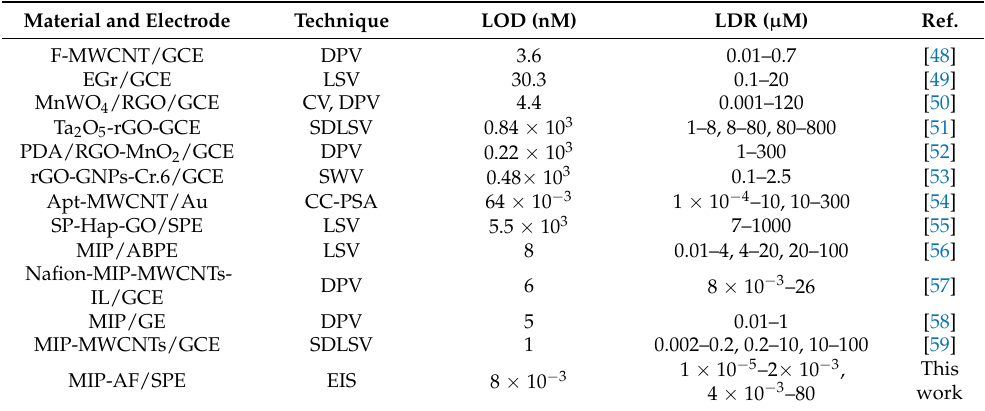
Figure 4. Calibration graph for analytical application and interference study carried out in 0.01 M PBS (pH 7.4); ( a ) calibration graph for determination of Trp concentration (0.00001–80 µ M); ( b ) calibration graph for determination of Trp higher concentration range of 0.004–80 µ M; ( c ) calibration graph for determination of Trp lower concentration range of 0.00001–0.002 µ M; ( d ) specificity and selectivity of MIP-AF biosensor were determined by incubating 0.5 µ M of tyrosine (Tyr) and phenylalanine (Phe) examined by MIP-AF/SPE biosensor in the presence or absence of 0.002 µ M of Trp. Table 1. Comparison of the proposed method (MIP-AF/SPE) with previously published electrochem- ical methods used for detection of